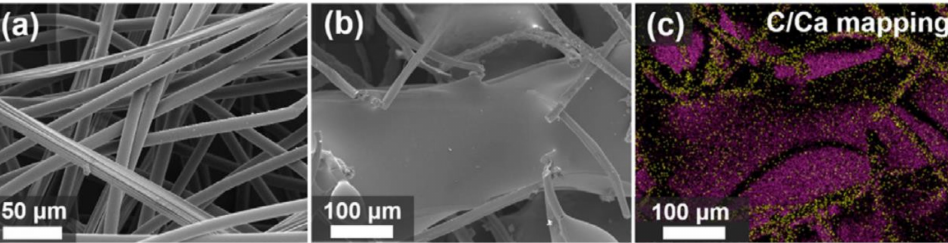
Figure 15. SEM images of polyester/alginate mixed fiber ( a ) before and ( b ) after the flammability test, and ( c ) EDX element mapping image (purple for carbon mainly from melt polyesters and yellow for calcium in fibrous charred